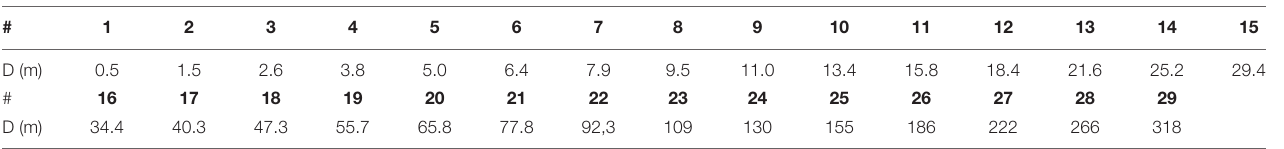
FIGURE 4 | (A) Absolute number of observations collected by sea turtles (NDATA) between January 2019 and April 2020 within the first 29 vertical layers (0–318 m) of Glo12 operational ocean model. The black profile shows the vertical density of the data (number.m − 1 , logarithmic scale, max = 29,024) within each layer. (B) Corresponding vertical profile of mean observed temperature with associated std values shown in gray. The corresponding model depths are shown on the right axis (red)—see Table 3 for the actual depth of all model layers. TABLE 3 | Depth (D, bottom of the layer) of Glo12 model levels